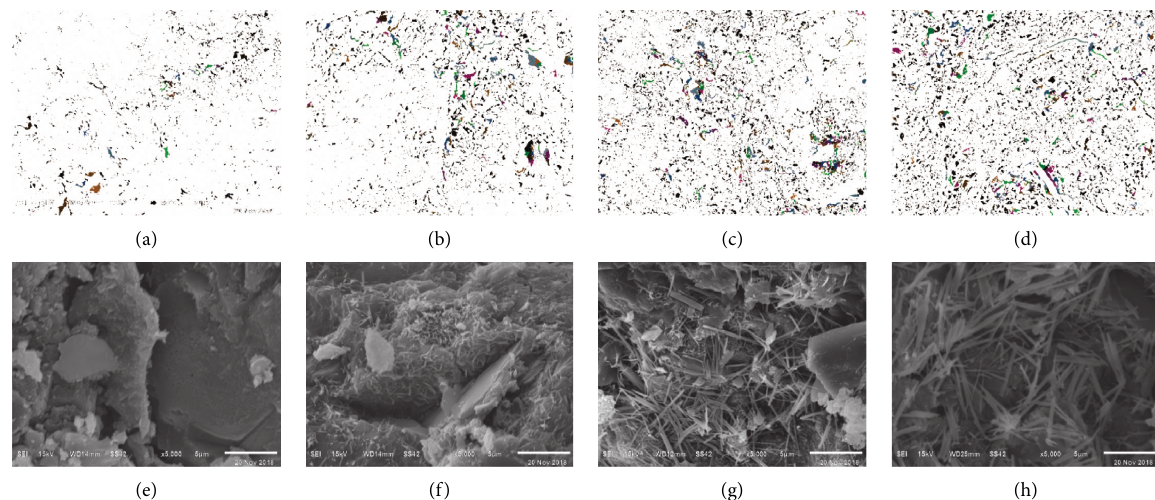
Figure 2: Micropore structure of hydrated cement paste (SEM 500X; SEM 5000X): (a) SEM 500X binary diagram for FTC00; (b) SEM 500X binary diagram for FTC25; (c) SEM 500X binary diagram for FTC50; (d) SEM 500X binary diagram for FTC75; (e) SEM 5000X diagram for FTC00; (f) SEM 5000X diagram for FTC25; (g) SEM 5000X diagram for FTC50; (h) SEM 5000X diagram for